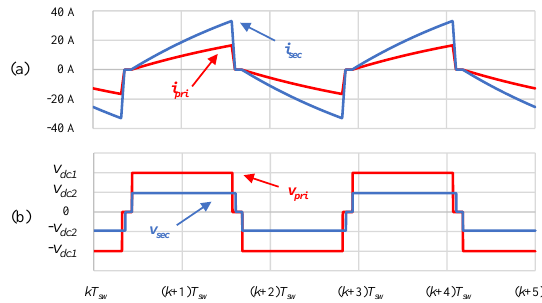
Figure 3. Waveforms in the primary and secondary sides of the HF transformer when the SAB operates under duty-cycle modulation: (a) Current; (b) Voltage. Figure 4 shows, respectively, the waveforms of the current in the resistive load ( i load_sec ) and of v dc2 . As observed, i load_sec has a mean value of 17.255 A and v dc2 of 191.8 V, which justifies the operating power value slightly below the previously established reference of 3.6 kW.